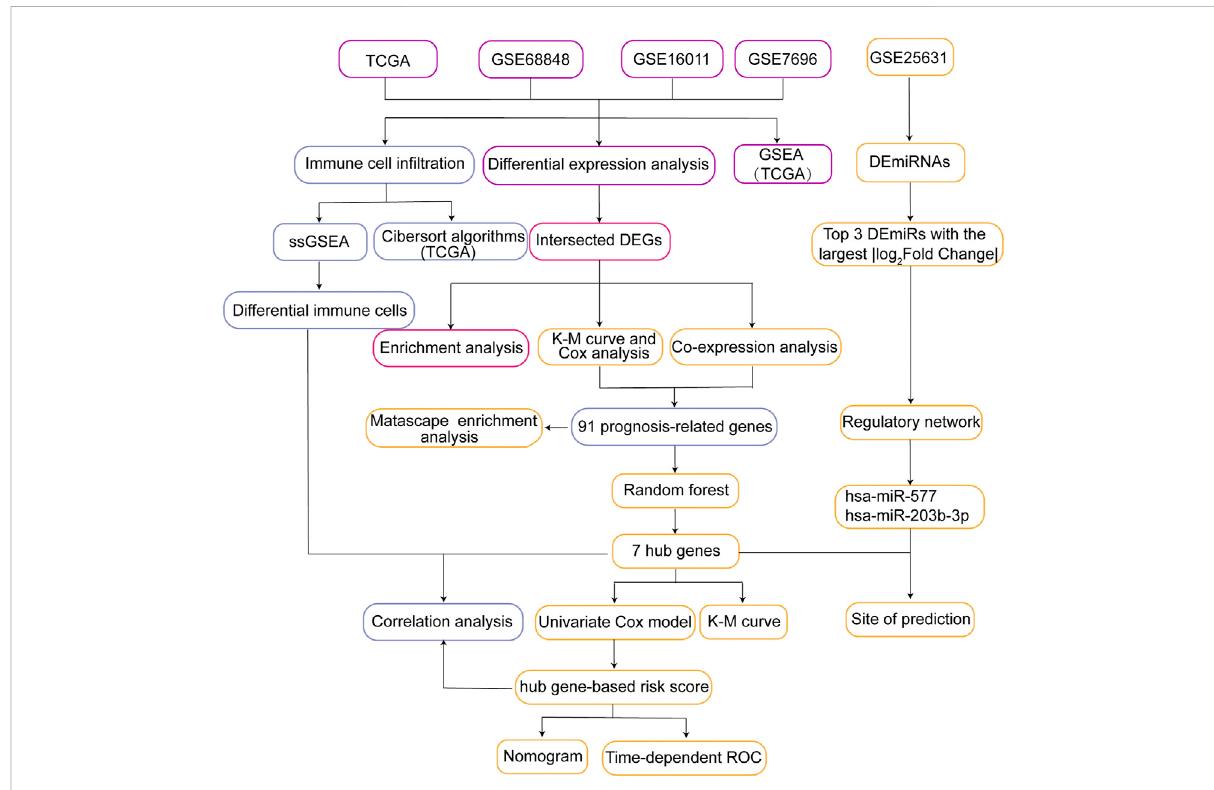
FIGURE 1 Flow chart of the present study. DEGs, differentially expressed genes; ssGSEA, single sample Gene Set Enrichment Analysis; GSEA, Gene Set Enrichment Analysis; K-M curve, Kaplan-Meier curve; Time-dependent ROC, Time-dependent receiver operating characteristic curve; TCGA, The Cancer Genome